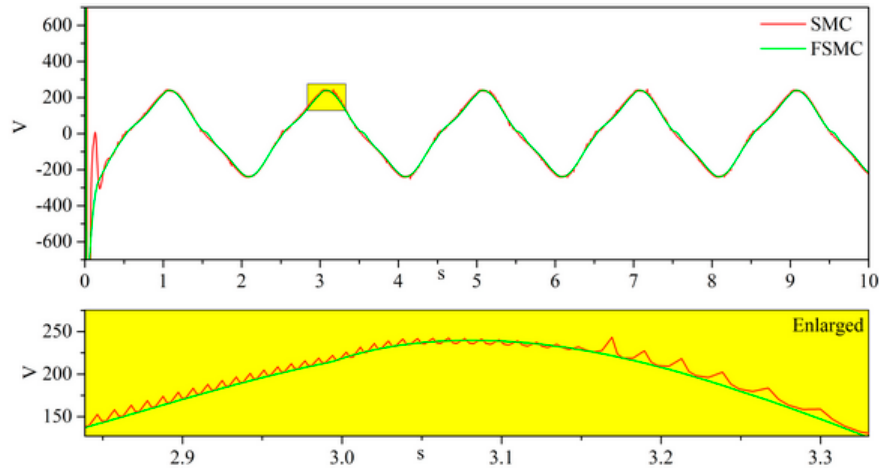
Figure 7. Output voltage of FSMC and SMC control under constant deviation fault (300 N · m ).